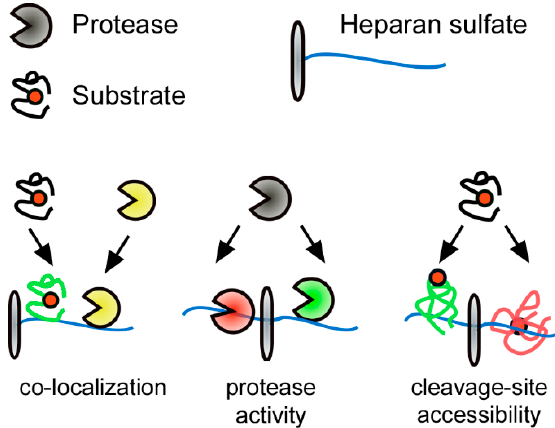
Figure 3. Heparan sulfate (HS)-protein interaction as a post translational regulator of extracellular proteolysis. Electrostatic interactions of proteins with negatively charged HS affect extracellular proteolysis at three different levels: (1) by mediating co-localization of reactants; (2) on the protease level by affecting protease activity/accessibility; or (3) on the substrate level by modulating accessibility to cleavage sites. The substrate cleavage site is indicated by a red circle, green substrate/protease color denotes activity; red substrate/protease color denotes inactivity/inaccessibility.